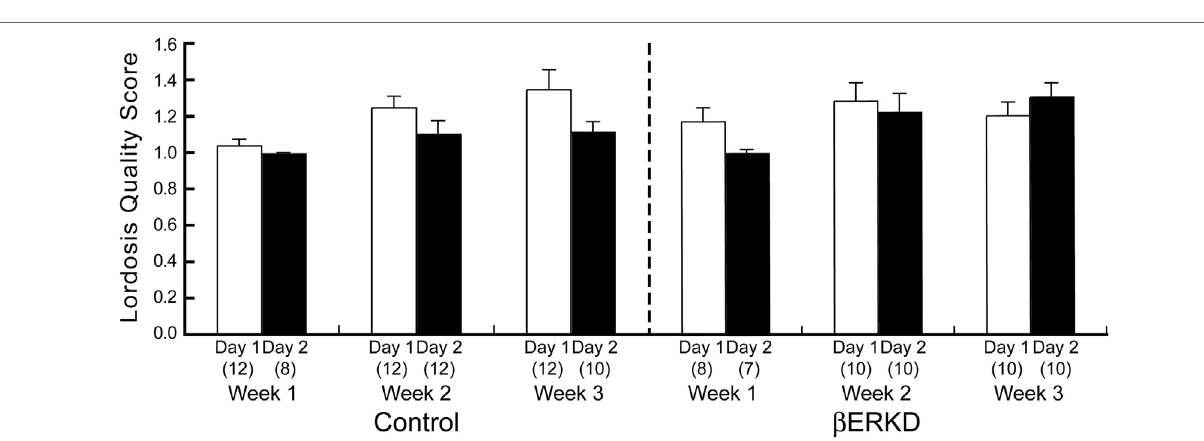
FigUre 6 | Lordosis Quality Score of control (left) and ER β knockouts (right) mice in each test. There was no difference between day 1 and day 2 in each week regardless of treatment group. The number in parentheses showed the number of mice which expressed lordosis (i.e., lordosis score of higher than 1) in each